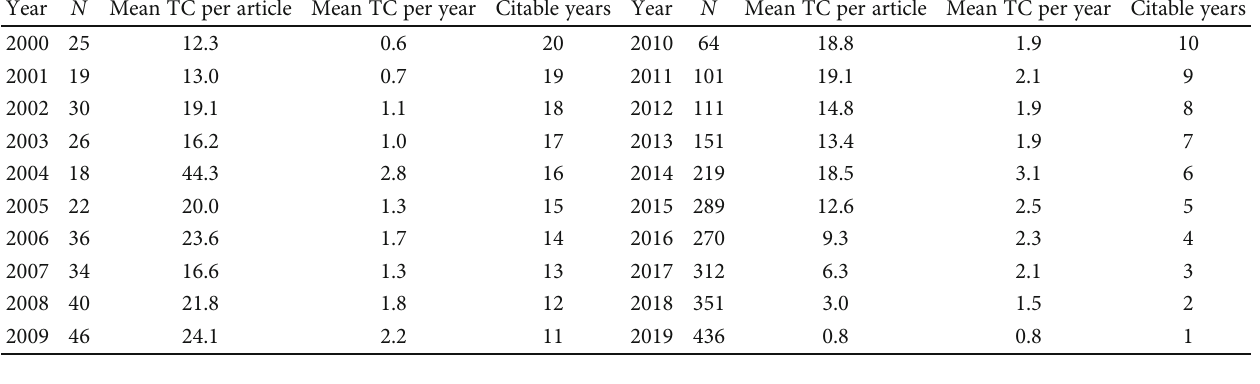
Table 2: Year-wise distribution of documents.